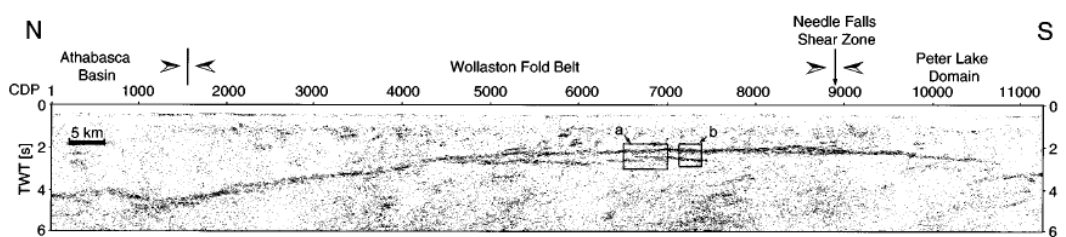
Figure 7. The Wollaston Lake reflector, imaged by LITHOPROBE seismic reflection profiling in Saskatchewan, NW Canada [62]. This feature can be traced as a distinct narrow band of reflections for 160 km within the Early Proterozoic Trans-Hudson hinterland. Based on its reflection character and tectonic context, it has been interpreted as a diabase sill associated with the 1.27 Ga McKenzie igneous event.